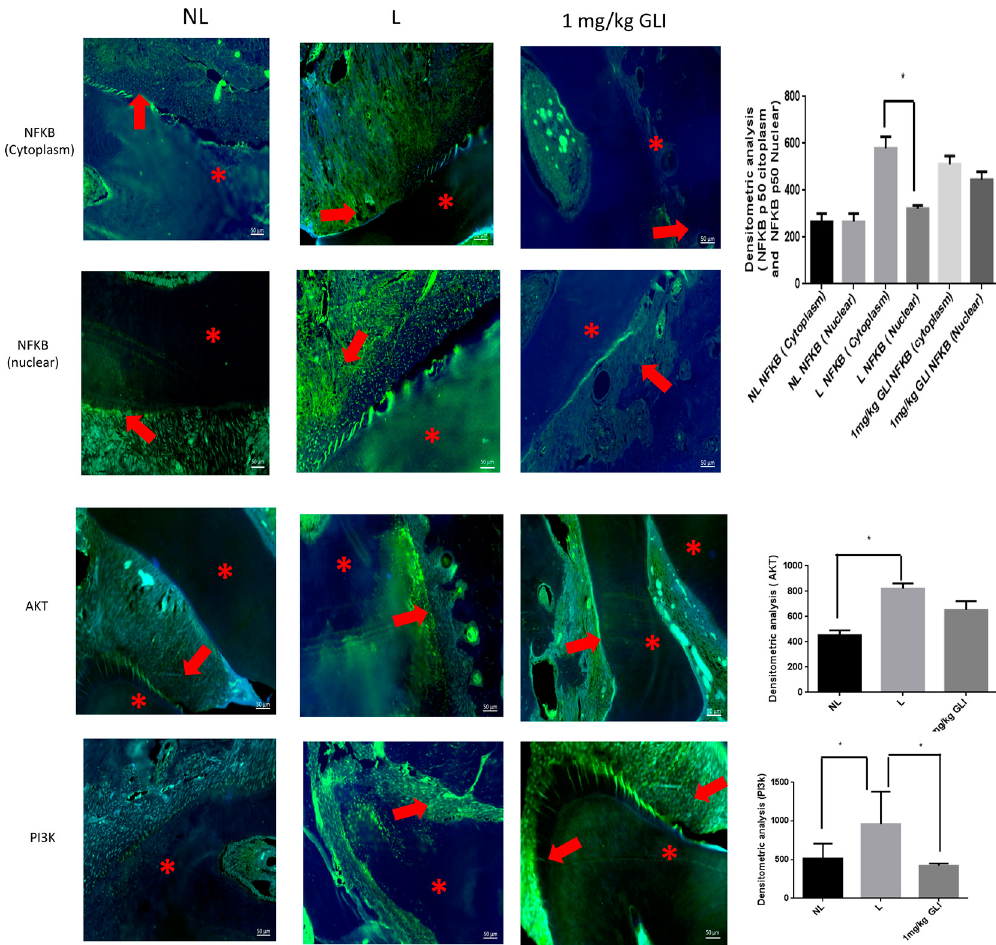
Figure 7- Gliclazide (GLI) modulates NFKB P50 (Cytoplasm), NFKB P50 (Nuclear), AKT, PI3K immunoreactivity in periodontal specimens from each group (green) with DAPI nuclear counterstaining (blue). Densitometry analysis confirmed significantly increased NFKB p50 (cytoplasm) immunoreactivity relative NFKB p50 (Nuclear) in the L group (p<0.05). Representative confocal photomicrographs of PI3K immunoreactivity was indicated by strong labeling in the periodontal area of samples from the L group. Discrete Pi3K labeling was observed in alveolar bone in samples from the NL group and weak, diffuse labeling was observed in samples from the 1 mg/kg GLI group, p<0.05. Asterisks: Dental tissue; Arrows (red): Cells. Scale bar 50 µm, 200× magnification. Five immunofluorescence sections from each animal (n=3/group) were analyzed. ***p<0.001, Kruskal-Wallis test followed by Dunn’s